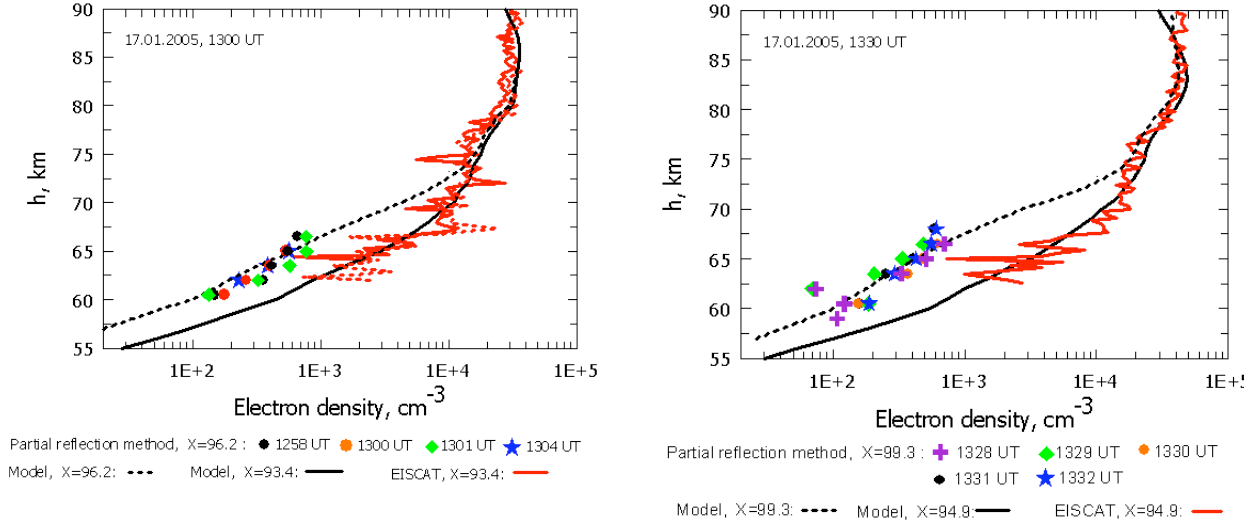
Fig. 10a. Electron density profiles measured (red solid curve and symbols) and calculated for the SPE on 17 January 2005 at 13:30UT for zenith angles 94.9 ◦ and 99.3 ◦ using the O, O 3 and NO profiles 4–6 in Fig. 1 (black curve).